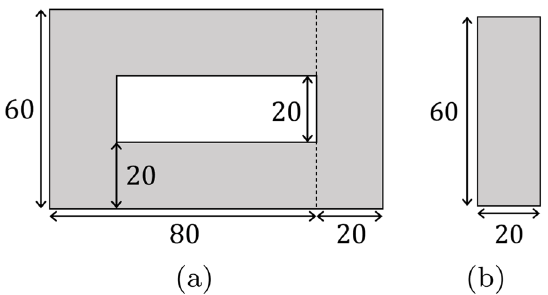
Fig. 12 Core geometry of the output transformer. All dimensions are in millimeters ( 10 − 3 m ). a Front view. b Side view